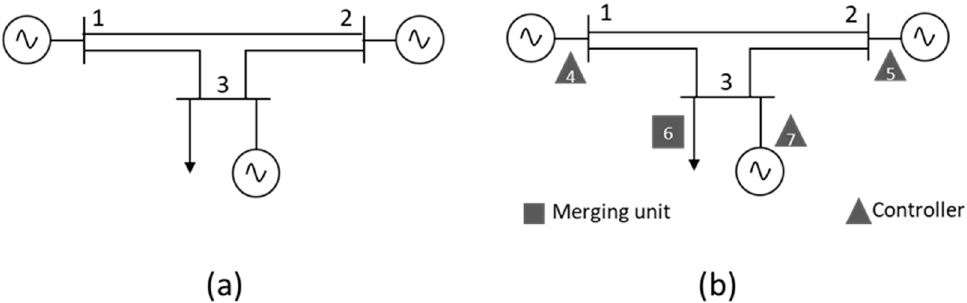
Figure 2. Three-bus smart grid representation with ( a ) electrical nodes and ( b ) electrical and OT-IT